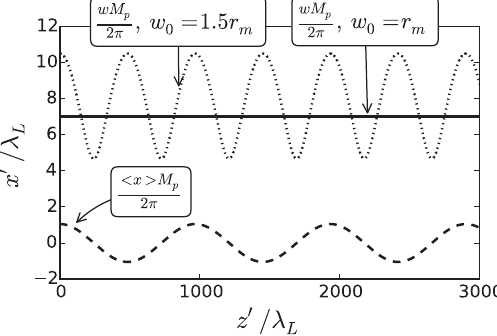
FIG. 1. Laser pulse centroid h x ið M p = 2 π Þ (dashed line) and laser spotsize w ð M p = 2 π Þ (dotted and solid lines) as functions of the propagation distance z 0 = λ L . Initial centroid displacement h x i ð M = 2 π Þ ¼ 1 . The channel parameters are chosen in such p 0 a way that the matched laser pulse spotsize is equal to r ð M = 2 π Þ ¼ 7 . Matched (solid line), with w m p matched (dotted line), with w 0 ¼ 1 . 5 r m cases are